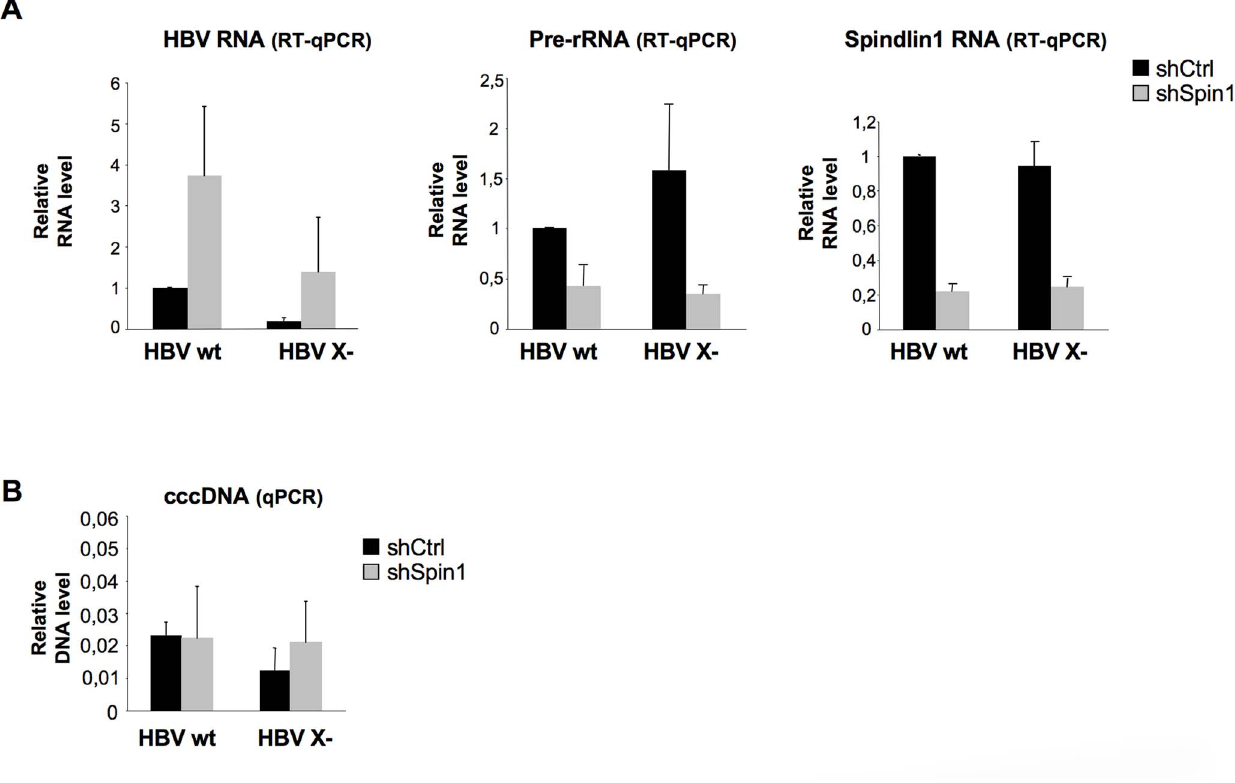
Figure 3. Endogenous Spindlin1 represses HBV transcription in the setting of infection. HepaRG cells stably expressing a shRNA control (shCtrl) or a pool of three shRNA directed against Spindlin1 (shSpin1) were established after transduction with the corresponding lentiviral vectors and selection with puromycin. Infections were then carried out with normalized amount of wild virus (HBV wt) or virus deficient for the expression of HBx (HBV X-). 8 days after infection, cells were harvested for total RNA extraction and cccDNA extraction. ( A ) HBV and pre-rRNA transcription were analyzed by RT-qPCR (left panel and middle panel respectively). Spindlin1 expression in shCtrl or shSpin1 HepaRG cells was analyzed by RT-qPCR (right panel). The relative transcription level was normalized with Roth2 cellular gene. Transcript level in shCtrl HepaRG cells infected with HBV wt was set to 1. Error bars represent SD of three independent experiments. ( B ) Nuclear DNA extraction. DNA was treated with plasmid safe before cccDNA amplification. The amount of cccDNA was quantified by qPCR and normalized to the amount of cyclin A. The cccDNA level in each condition was analyzed by qPCR using primers that amplify the cccDNA. The cccDNA level in shCtrl HepaRG cells infected with HBV wt was set at 1. Error bars represent SD of three independent